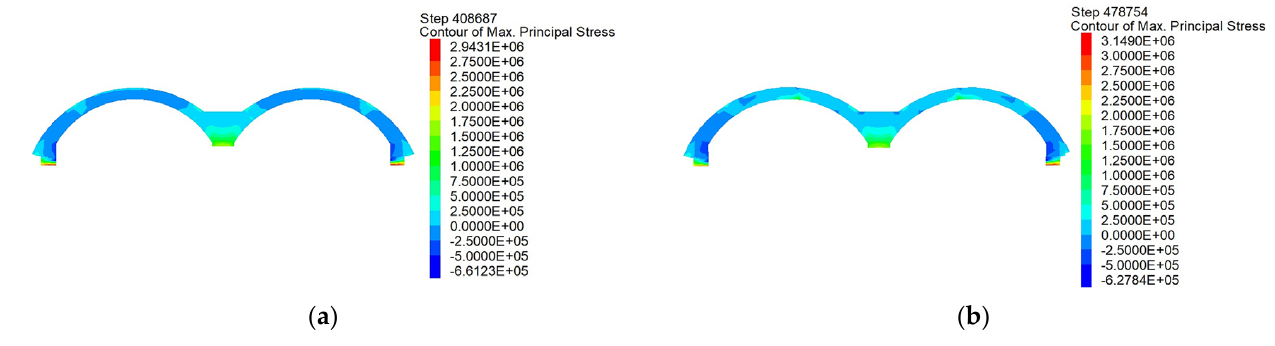
Figure 22. Comparison of maximum principal stresses of the arches completed in ( a ) one and ( b ) two attempts.